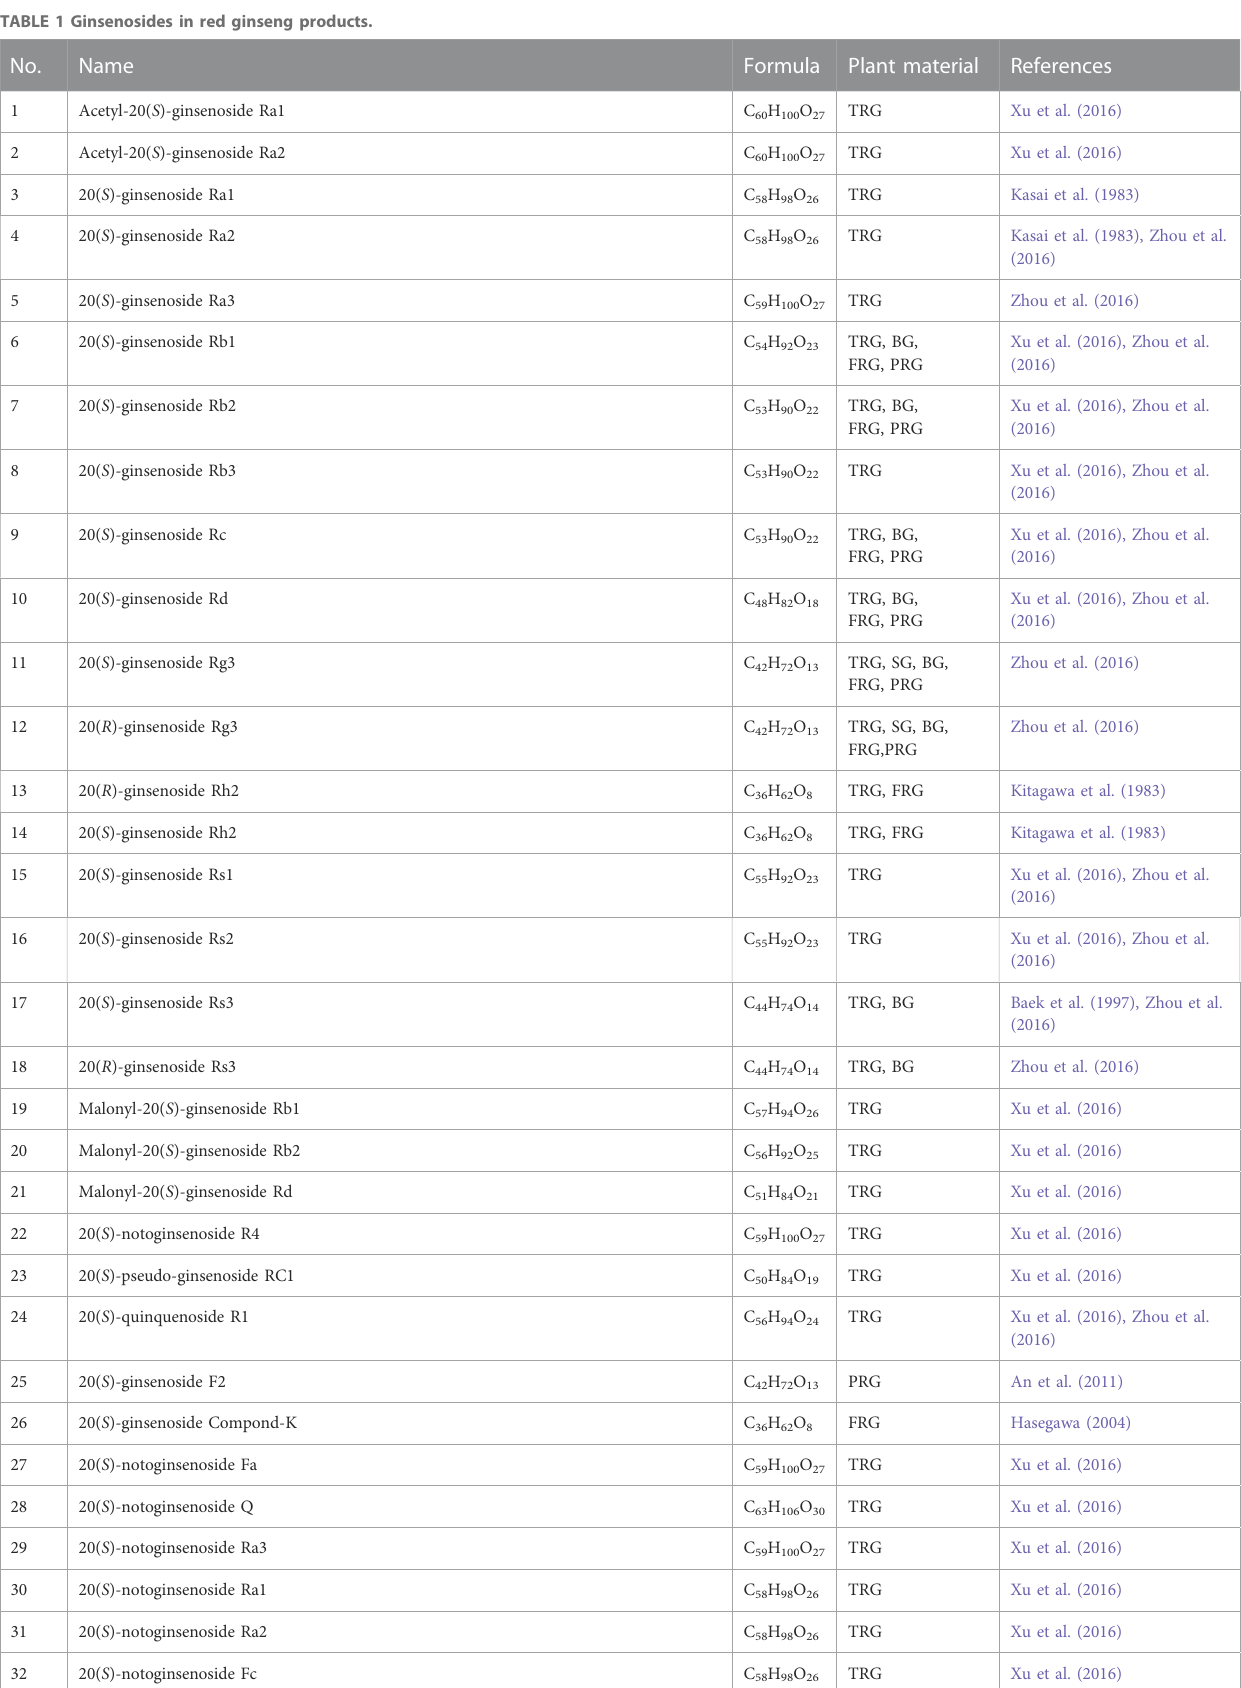
TABLE 1 Ginsenosides in red ginseng